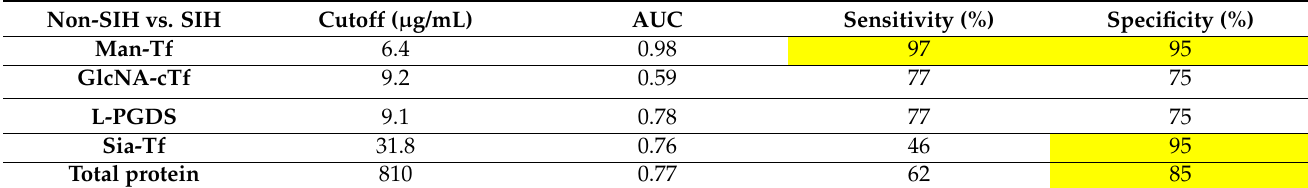
Table 7. Diagnostic accuracy for differentiating SIH and non-SIH in patients.